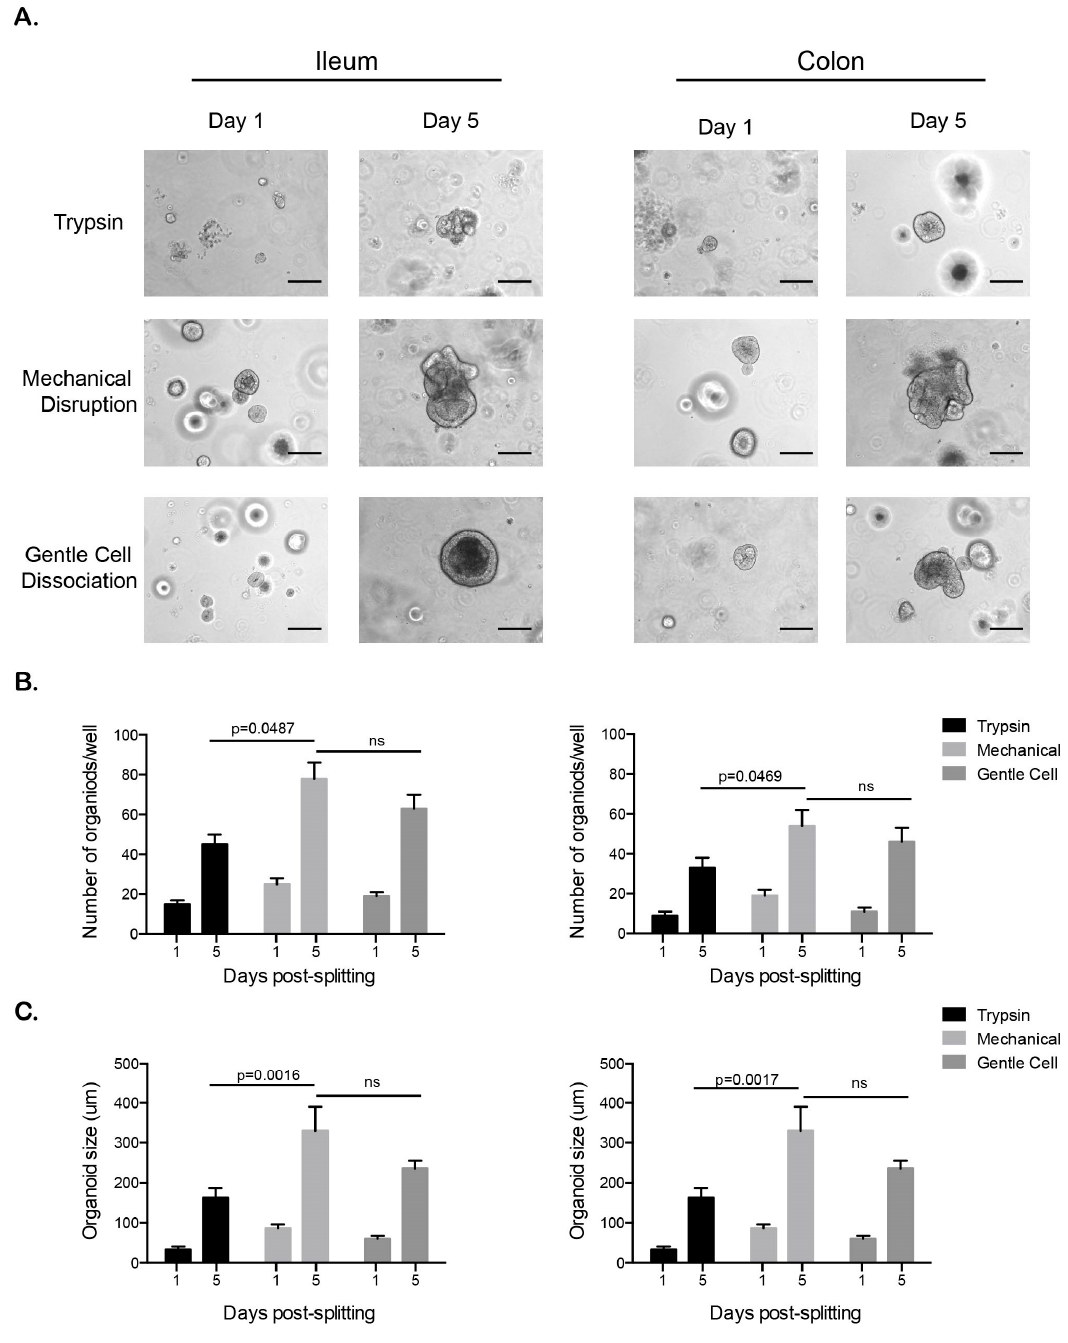
Figure 3. Mechanical disruption is the preferred method for passaging feline organoids. ( A – C ). Feline ileum- and colon-derived organoids were grown for 10 days post-harvesting prior to passaging. Three methods of passaging were used, and new organoids were followed over five days. ( A ). Bright field images of ileum and colon organoids. Representative images are shown. N = 3 donors and each donor were followed overtime as a triplicate series. Scale bar = 100 µm ( B ). The number of organoids from each passing method was counted over the indicated time course. Results are mean +/ − s.d. (n = 3 donors). ( C ). The size of the organoids was determined using a Nikon Eclipse Ti-S. Results are mean +/ − s.d. (n = 3